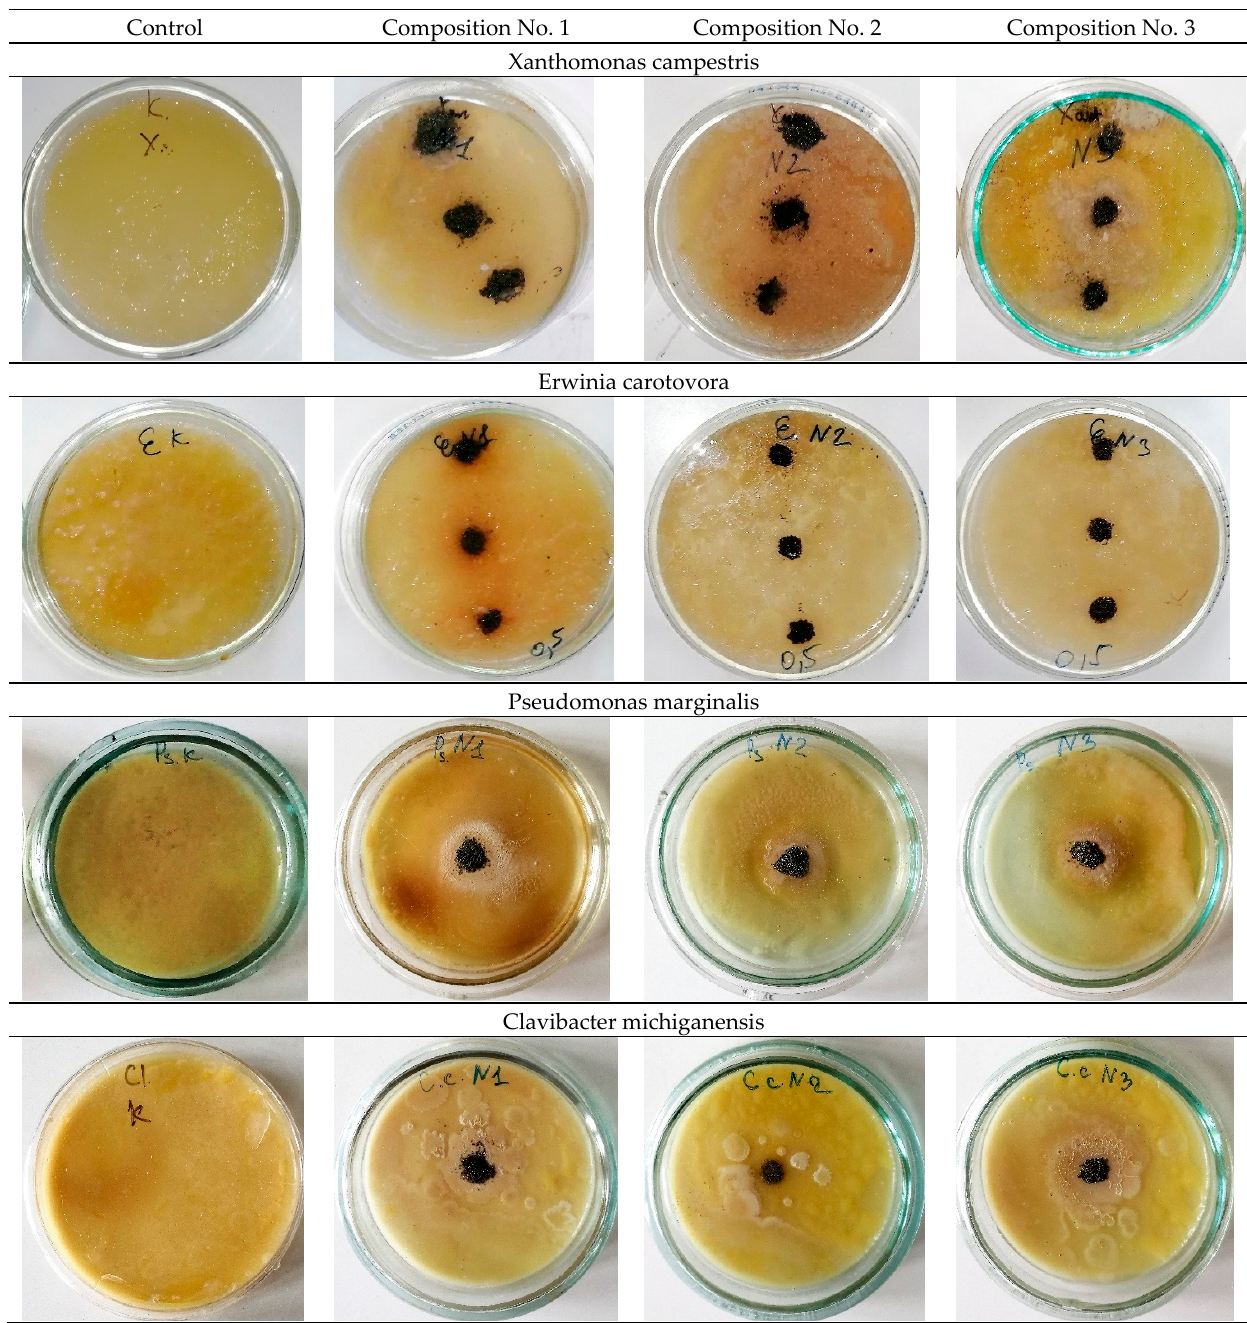
Figure 6. Samples of plates in bacterial suspensions (No.1—316L; No. 2—316L +0.2 wt.% Ag; No. 224 3—316L +0.5 wt.% Ag).